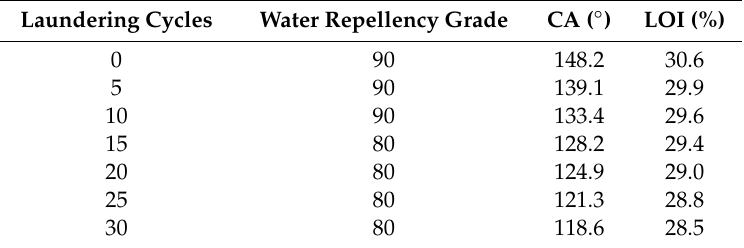
Table 4. Water-repellent and flame-retardant properties of treated cotton fabrics after different laundering cycles.